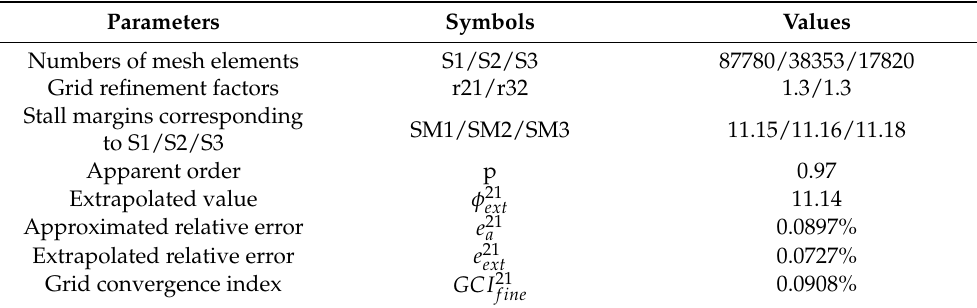
Table 2. Analysis of grid convergence in